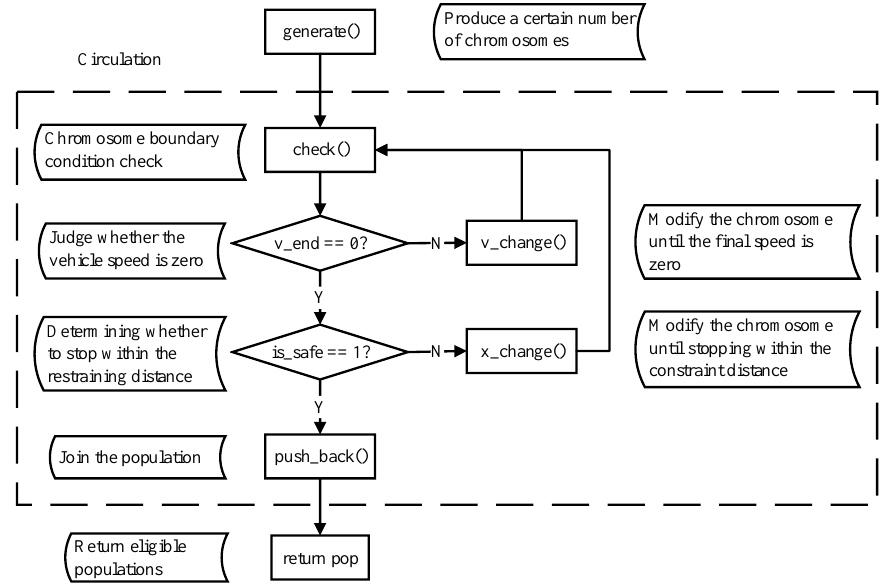
Figure 13. Establishment flow chart of initial population.